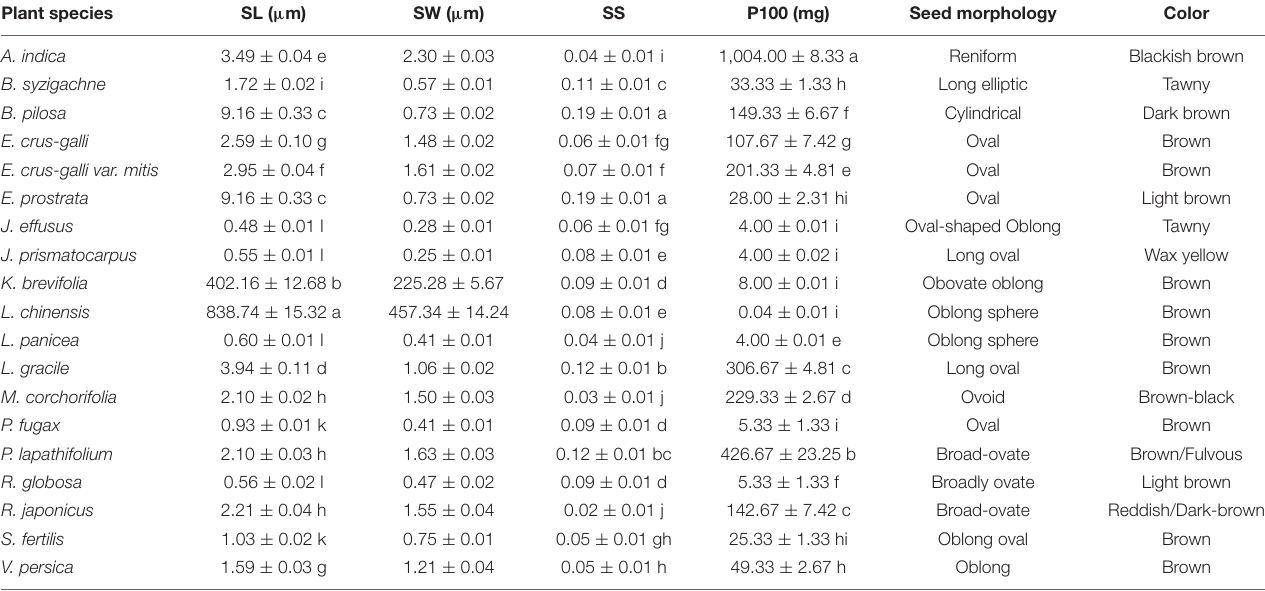
TABLE 2 | Seed length (SL), seed width (SW), seed height (SH), seed shape (SS), fresh weight of 100 seeds (P100), seed morphology, and seed color measured in 19 plant species. Plant species